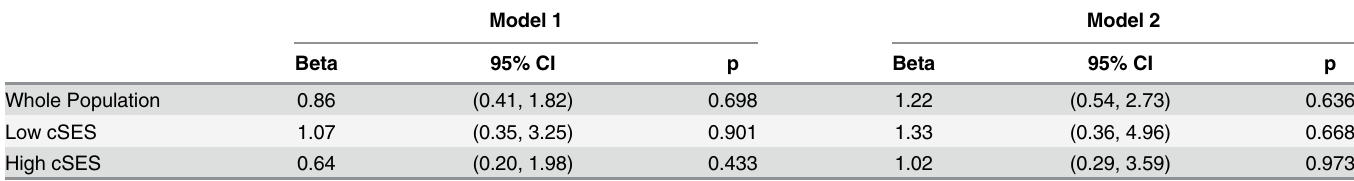
Table 5. Results for odds of elevated depressive among GI Bill eligible veteran wives compared to non-veteran wives when cSES is dichotomized by father ’ s education.